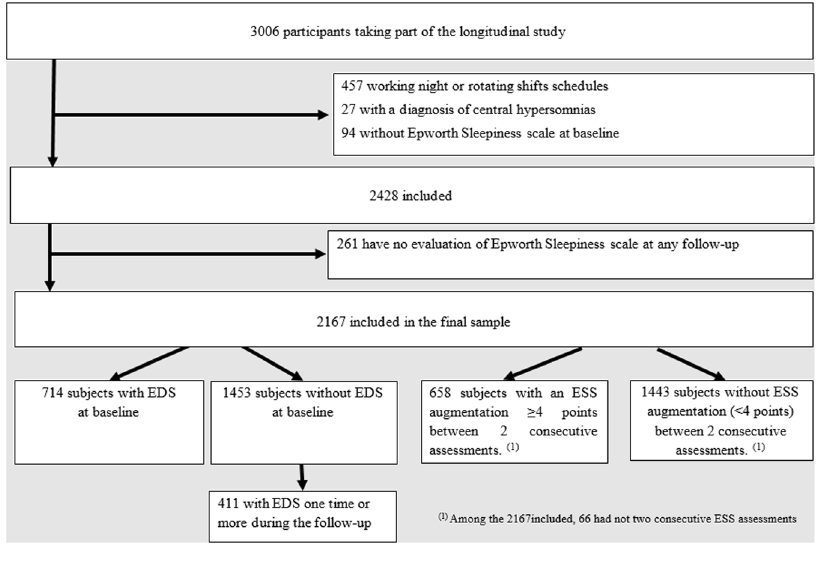
Figure 1. Flow chart